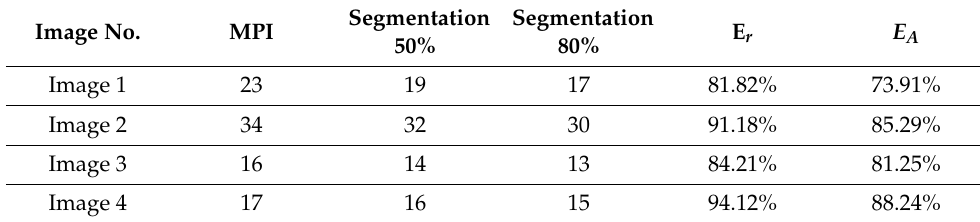
Table 2. Accuracy